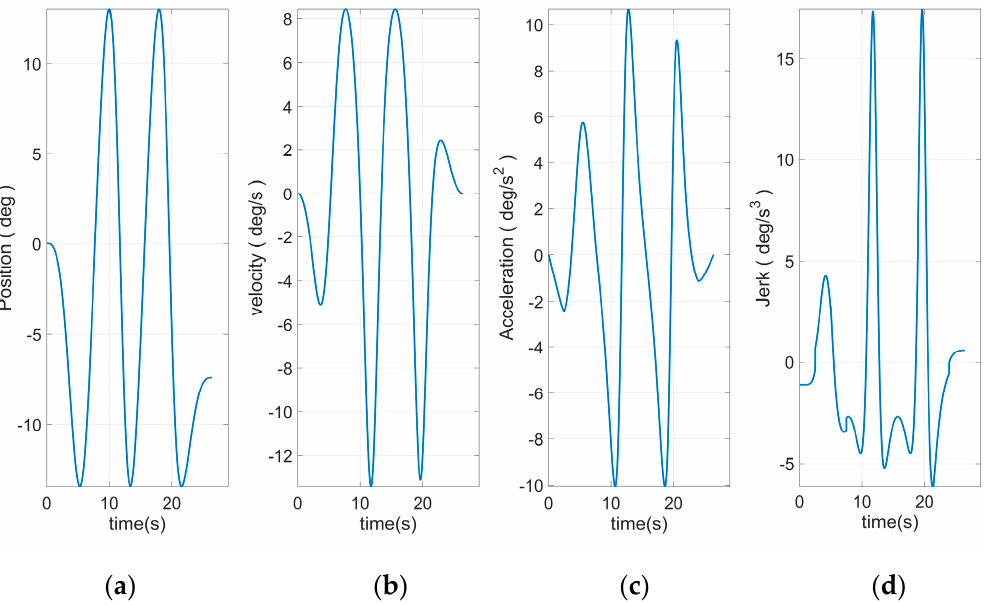
Figure 20. ( a ) Displacement of axis I over time by using seven segments S-curve. ( b ) Velocity of axis I over time by using seven segments S-curve. ( c ) Acceleration of axis I over time by using seven segments S-curve. ( d ) Jerk of axis I over time by using seven segments S-curve.